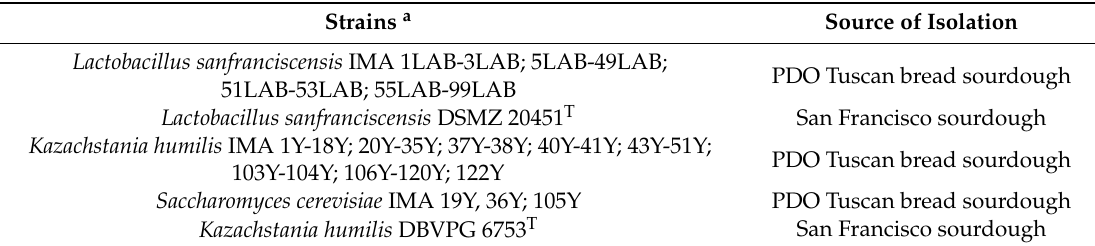
Table 1. Lactic acid bacteria and yeast strains used in this